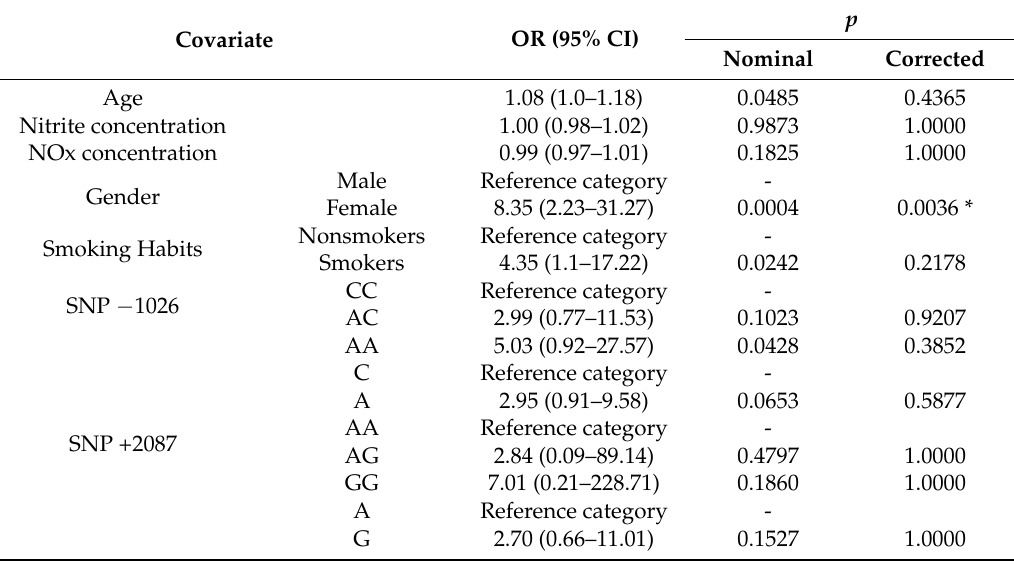
Table 3. Logistic regression results of the